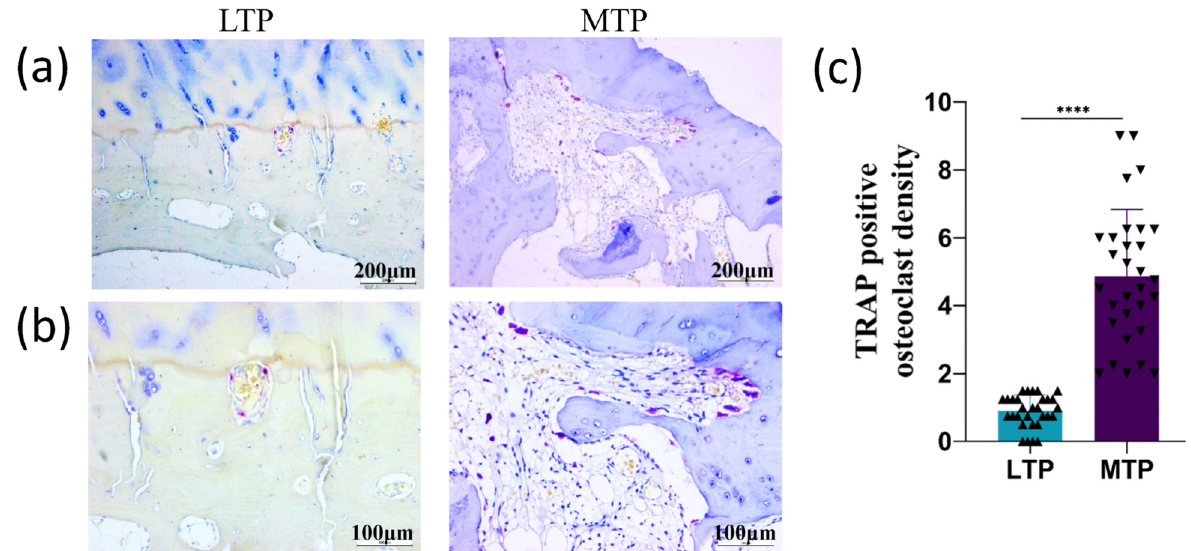
Figure 3: Comparison of TRAP - positive osteoclasts in the subchondral bone of LTP and MTP. ( a ) A large number of TRAP - positive cells were distributed in the MTP subchondral bone. In the LTP subchondral bone, TRAP - positive cells were rarely distributed. ( b ) TRAP - positive cells mainly distributed in the MTP subchondral bone absorption pit region. TRAP - positive cells mainly distributed at the junction of cartilage and subchondral bone in the LTP. ( c ) TRAP - positive osteoclasts were signi fi cantly higher with MTP compared to LTP. ( a ) Magni fi cation × 100, scale bar 200 µm; ( b ) magni fi cation × 200, scale bar 100 µm; **** P <